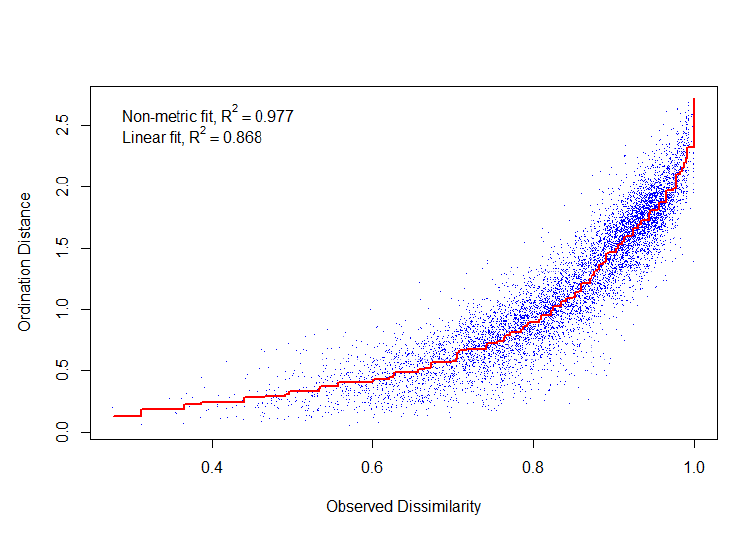
Figure A1.2: Shepard diagram resulted from non-metric multidimensional scaling analysis to plot the ordination distance and linear fit line of vegetation data against the original